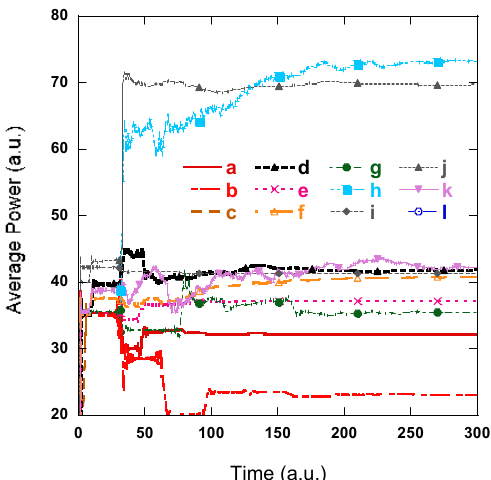
Figure 7. Average power of light extracted in 10 structures, while the PSS width, w = 2.5 µ m, and period, d = 3 µ m. The SiO 2 layer is centered at z = 7.8 µ m. Sapphire layer thickness is 80 µ m. ( a ) CLED, ( b ) CLED with Ag between U-GaN and the sapphire substrate, ( c ) CLED with Ag below the sapphire substrate, ( d ) NR, ( e ) PSS, ( f ) PSS NR, ( g ) PSS with Ag between U-GaN and the sapphire substrate, ( h ) NR